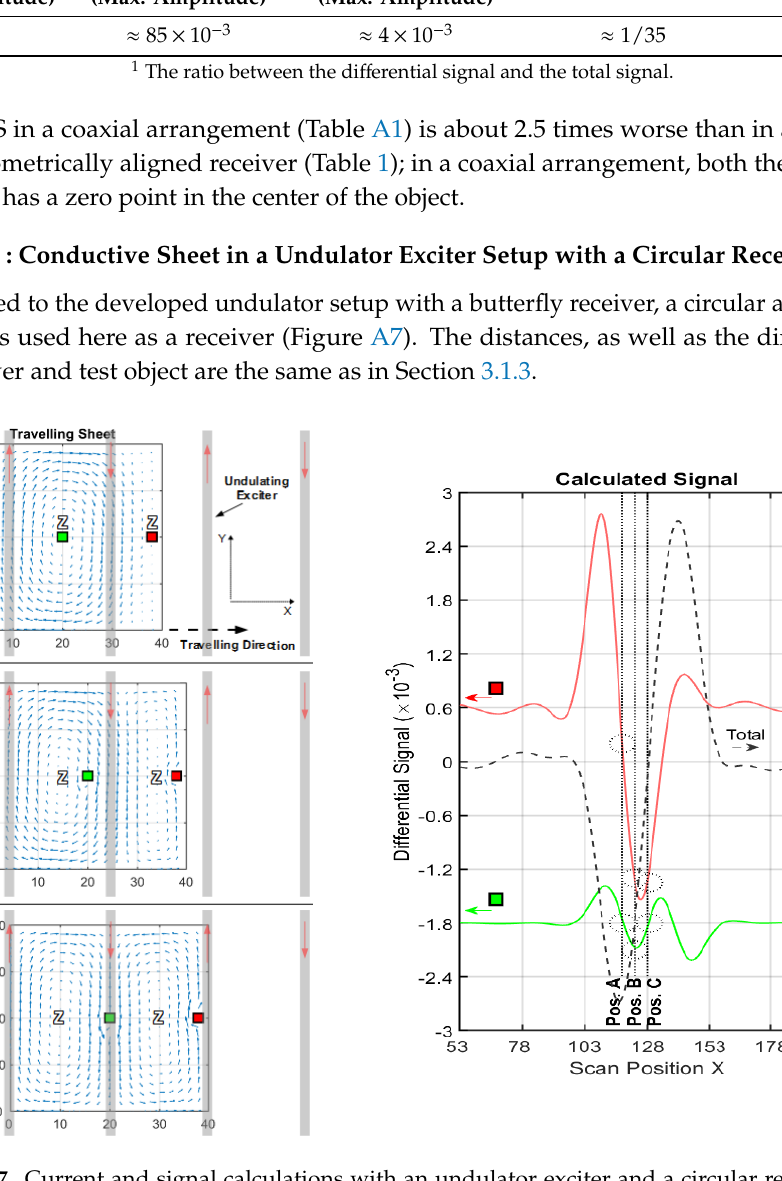
Table A1. Main results from the calculated signals, shown in Figure A6. Total Signal